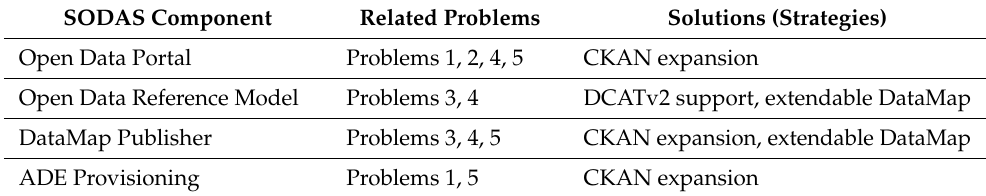
Table 1. Relationships among the problems, core strategies, and SODAS